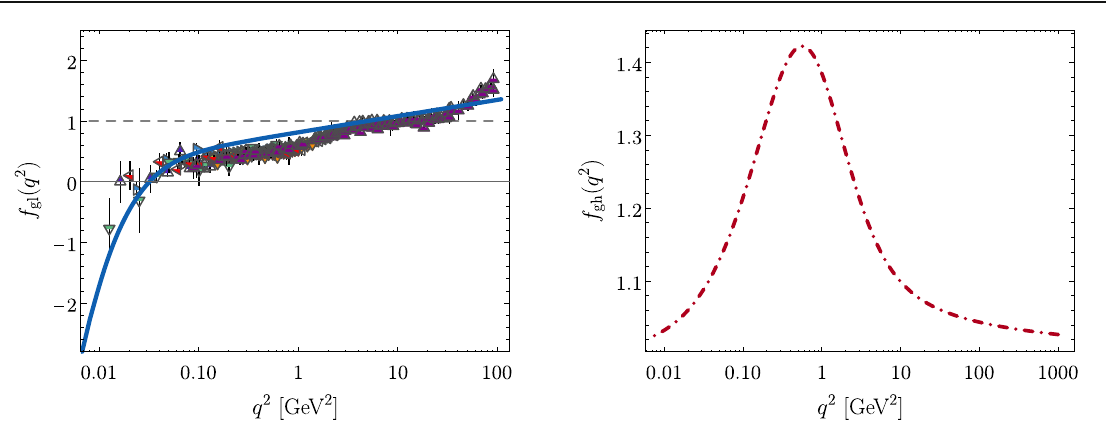
and (cid:2) S (cid:4)